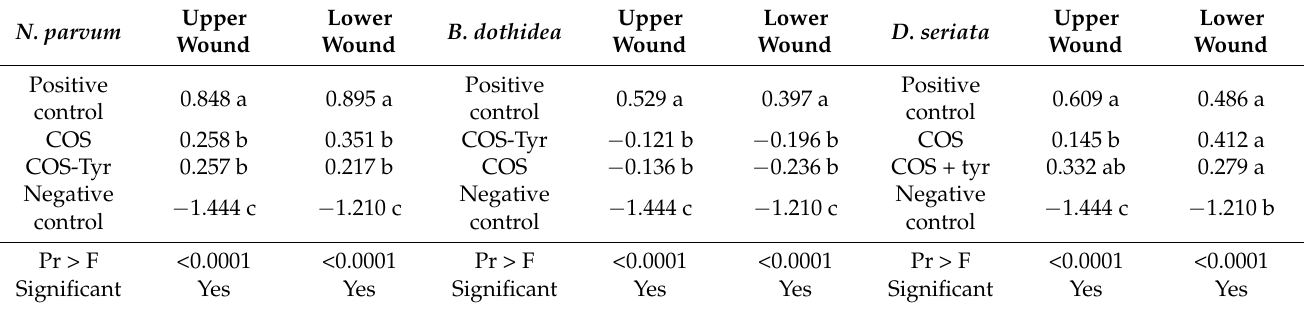
Table 2. Analysis of variance (ANOVA) of the lengths of vascular necroses for N. parvum (left), B. dothidea (center) and D. seriata